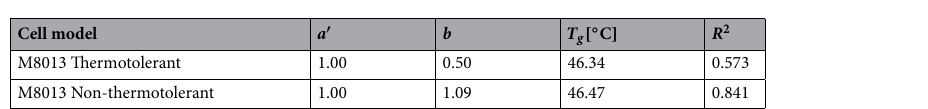
Table 2. Parameters of the TER model Eq. (19), obtained from M8013 mouse mammary carcinoma in vitro 59 .